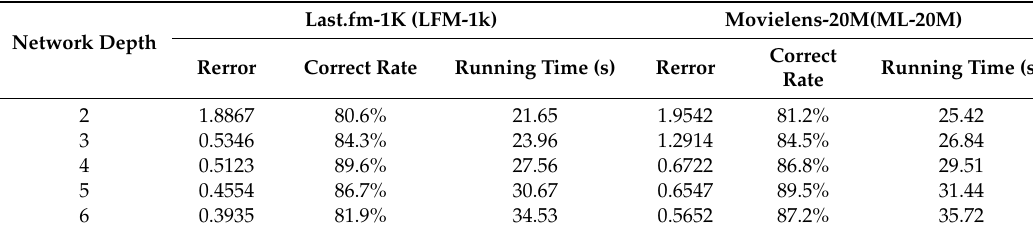
Table 1. Improved deep belief network (IDBN) training results of di ff erent